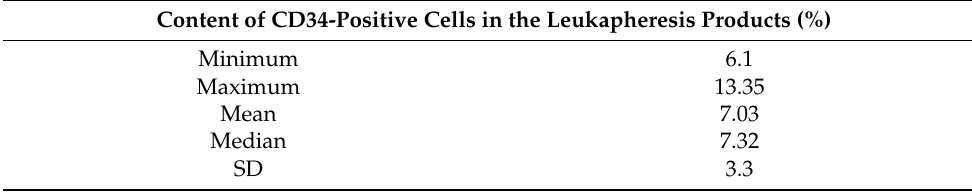
Table 1. The percentage content of CD34+ cells in the graft material obtained from 40 patients.